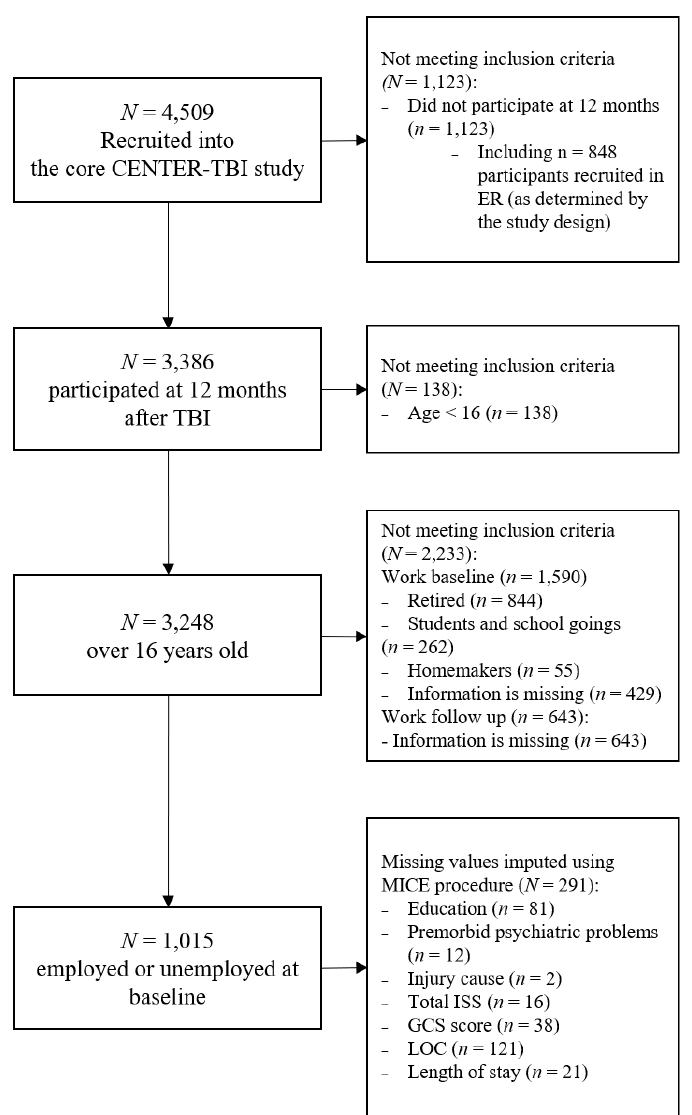
Figure 1. Sample flow chart diagram. Abbreviations: N = number ( n = number in subgroups); ISS = Injury severity score; GCS = Glasgow Coma Scale; LOC = Loss of consciousness; Length of stay = Length of stay in the hospital.